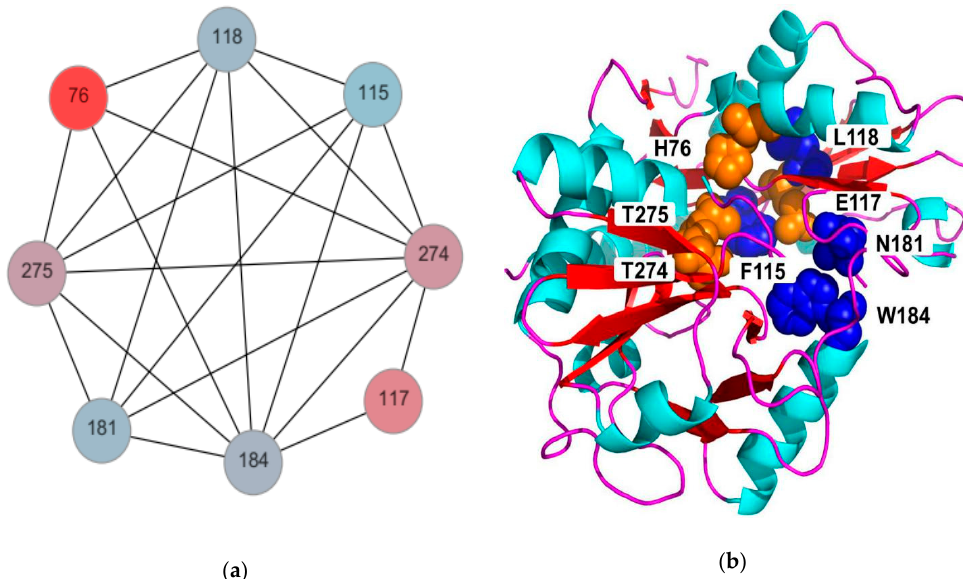
Figure 1. Putative important residues in ( R )-selective amine transaminases (AT-ATA) identified by conservation, mutual information (MI), cumulative MI (cMI), and proximity MI (pMI) scores from the PF01063 MI network: ( a ) The subnet consisted of eight strongly interacting residues. The amino acids in circles are colored from cyan to red, corresponding to lower to higher degrees of conservation. ( b ) The eight residues with strong interactions were visualized in the crystal structure of AT-ATA (PDB ID: 4CE5) using the program PyMOL (http://pymol.org).